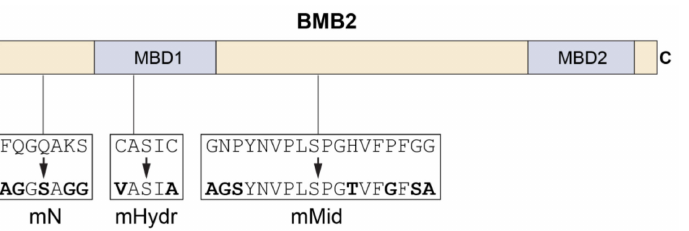
Figure 4. Schematic representation of BMB2 mutants used in this study. The BMB2 sequence is shown as a box with the positions of protein membrane-binding domains (MBD1 and MBD2) indicated. The N-terminal, central and C-terminal hydrophilic regions are shown in yellow color. Boxes below the BMB2 schematic drawing show amino-acid substitutions introduced into the BMB2 sequence to generate mutants BMB2-mN, BMB2-mHydr and